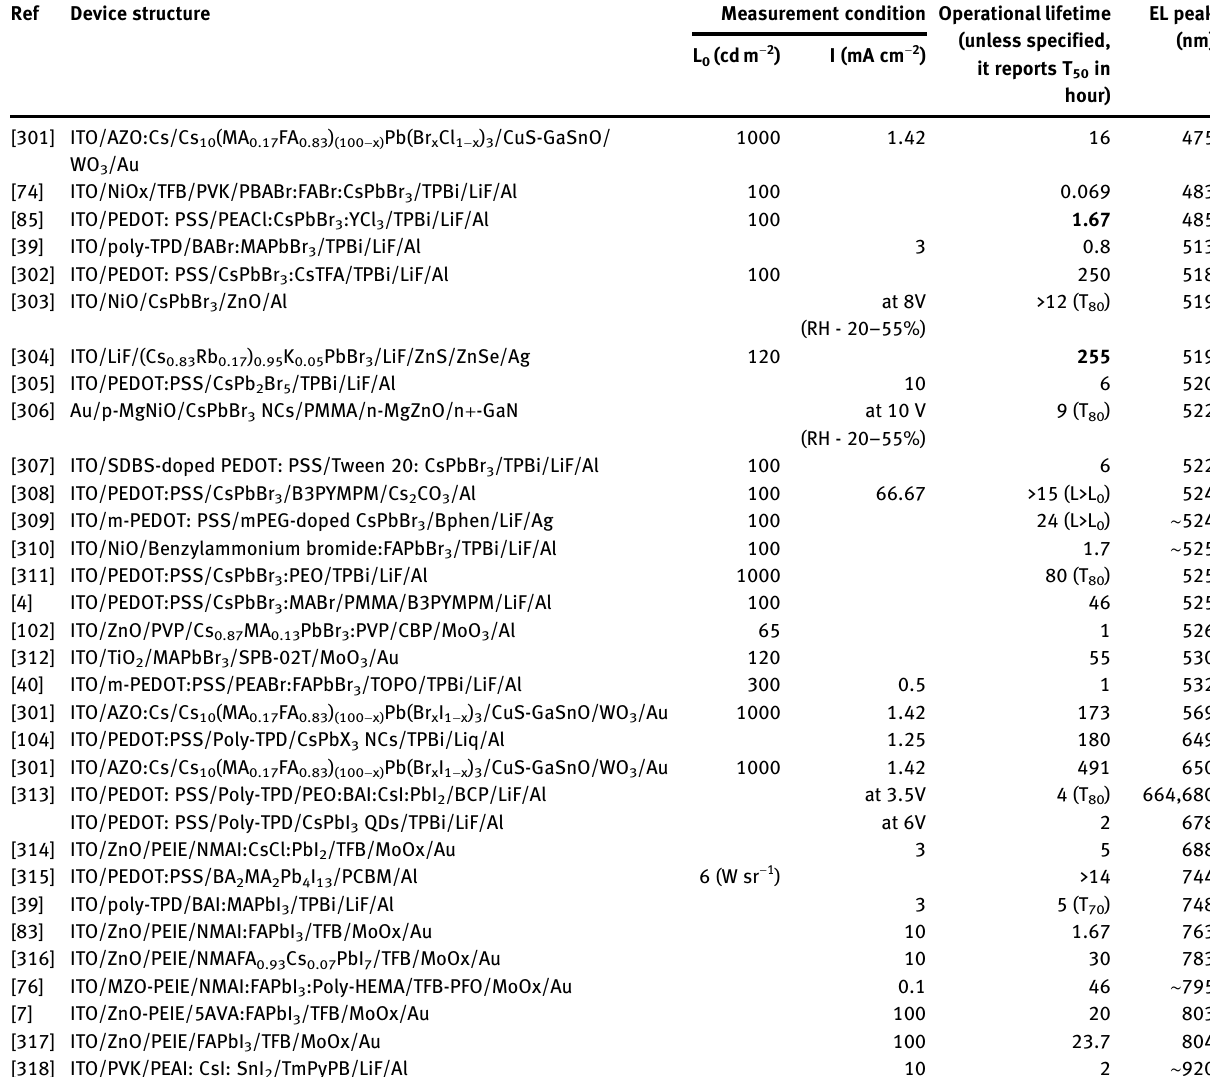
Table  : Summary of device performance and operational stability of perovskite LEDs in literature. Ref Device